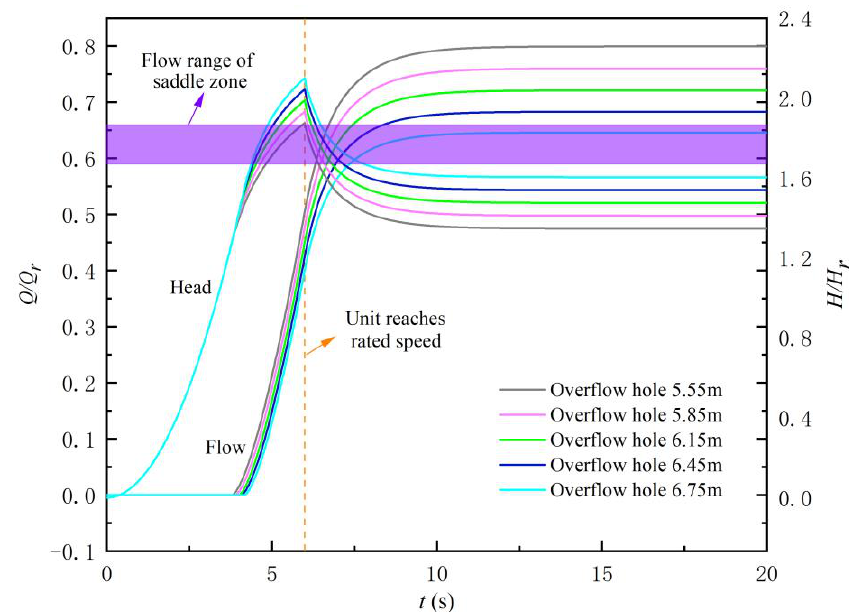
Figure 8. Variation pattern of flow and head of LAPS equipped with OVHO under gate refusal working condition.